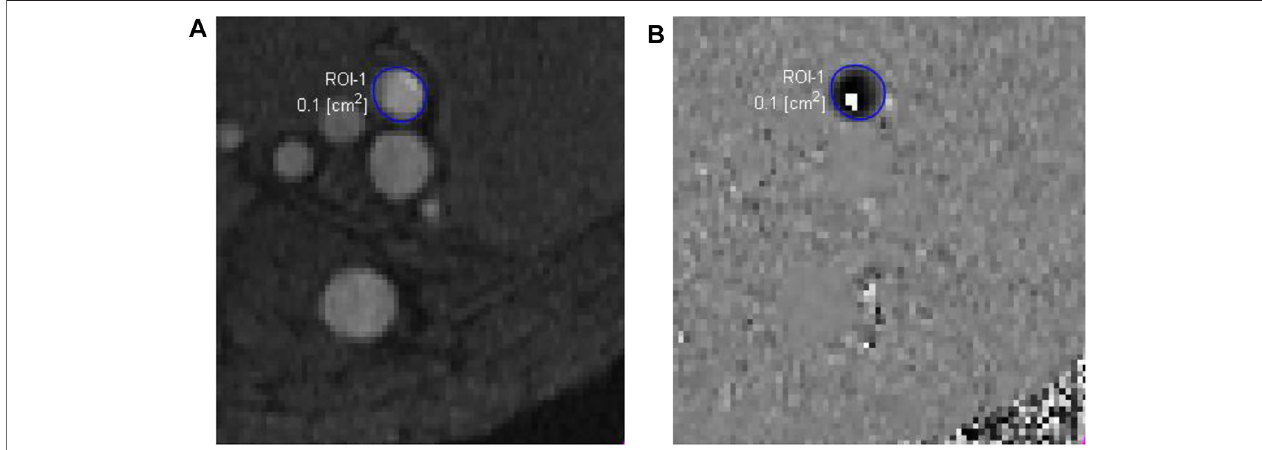
FIGURE 3 | Phase-contrast magnetic resonance images of an arteriovenous fi stula. The magnitude image (A) is used to draw a region of interest (ROI-1) for the proximal artery (enclosed by the blue circle), which may have very high fl ow velocity. In this case, the velocity encoding value, 250 cm/s, was not big enough, causing a phase-wrap artifact shown by the white pixels within the ROI-1 in the phase image (B)